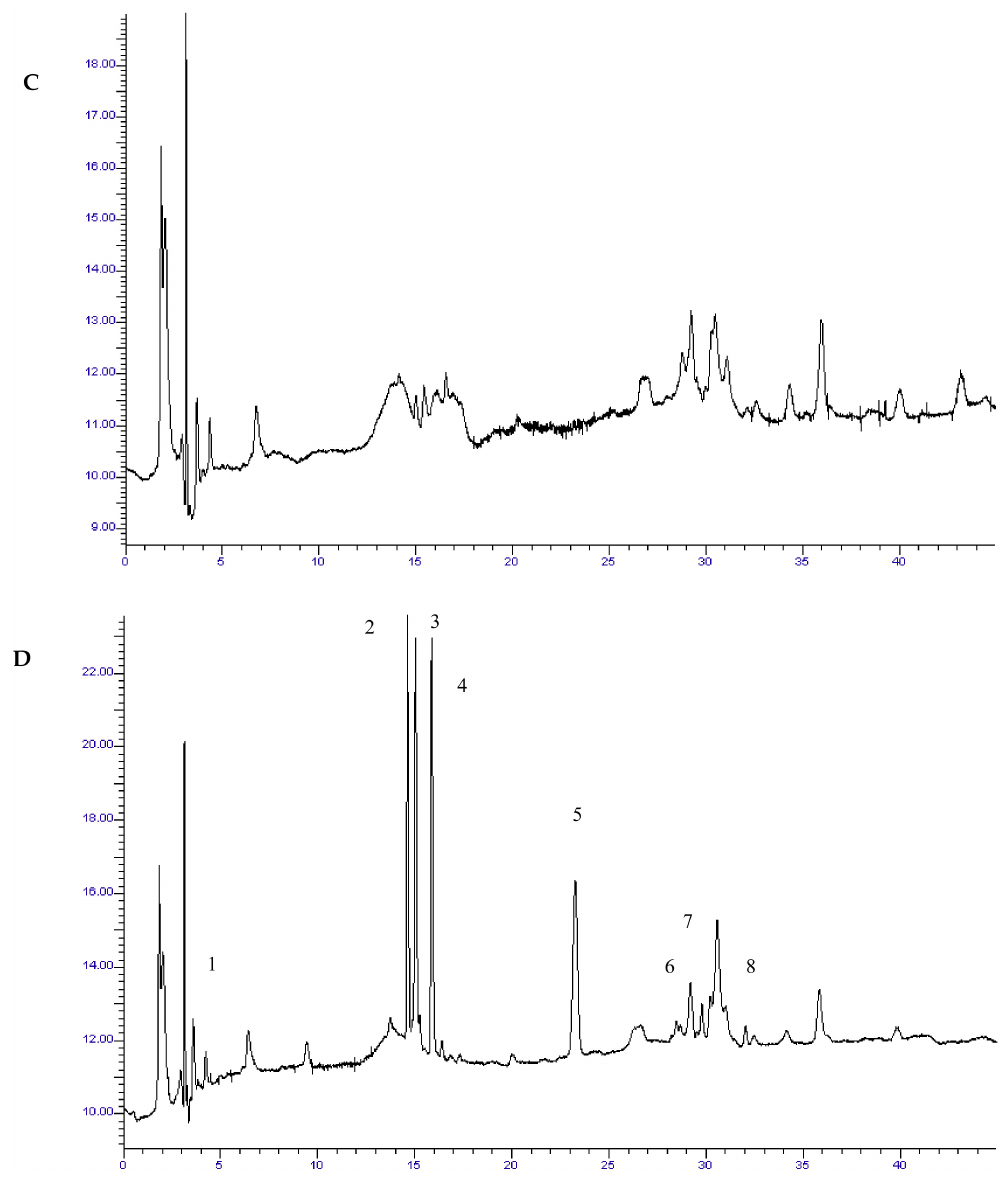
Figure 1. Chromatogram of blank milk sample at 240 nm. ( B ) Chromatogram of spiked milk sample with standard solution of target analytes (250 µ g kg − 1 ) at 240 nm. ( C ) Chromatogram of blank milk sample at 265 nm. ( D ) Chromatogram of spiked milk sample with standard solution of target analytes (250 µ g kg − 1 ) at 265 nm. Peaks: 1. AMO: 3.2 min, 2. CFZ: 14.8 min, 3. CFN: 15.2 min, 4. CFP: 15.8 min, 5. CFU: 22.5 min, 6. OXA: 29.8 min, 7. CAP: 30.4 min, 8. CLO: 32.3